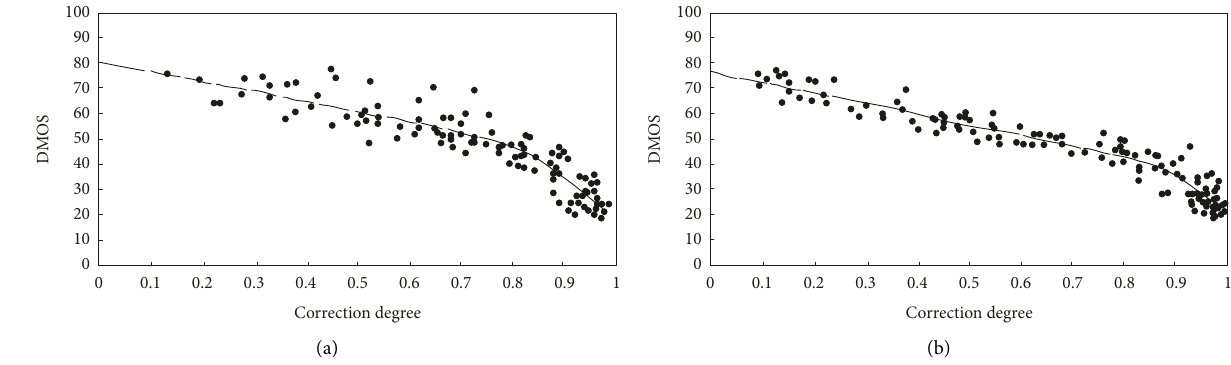
Figure 6: Edge correction scatter diagram of fast fading distorted image. (a) Control group. (b) Experience group.